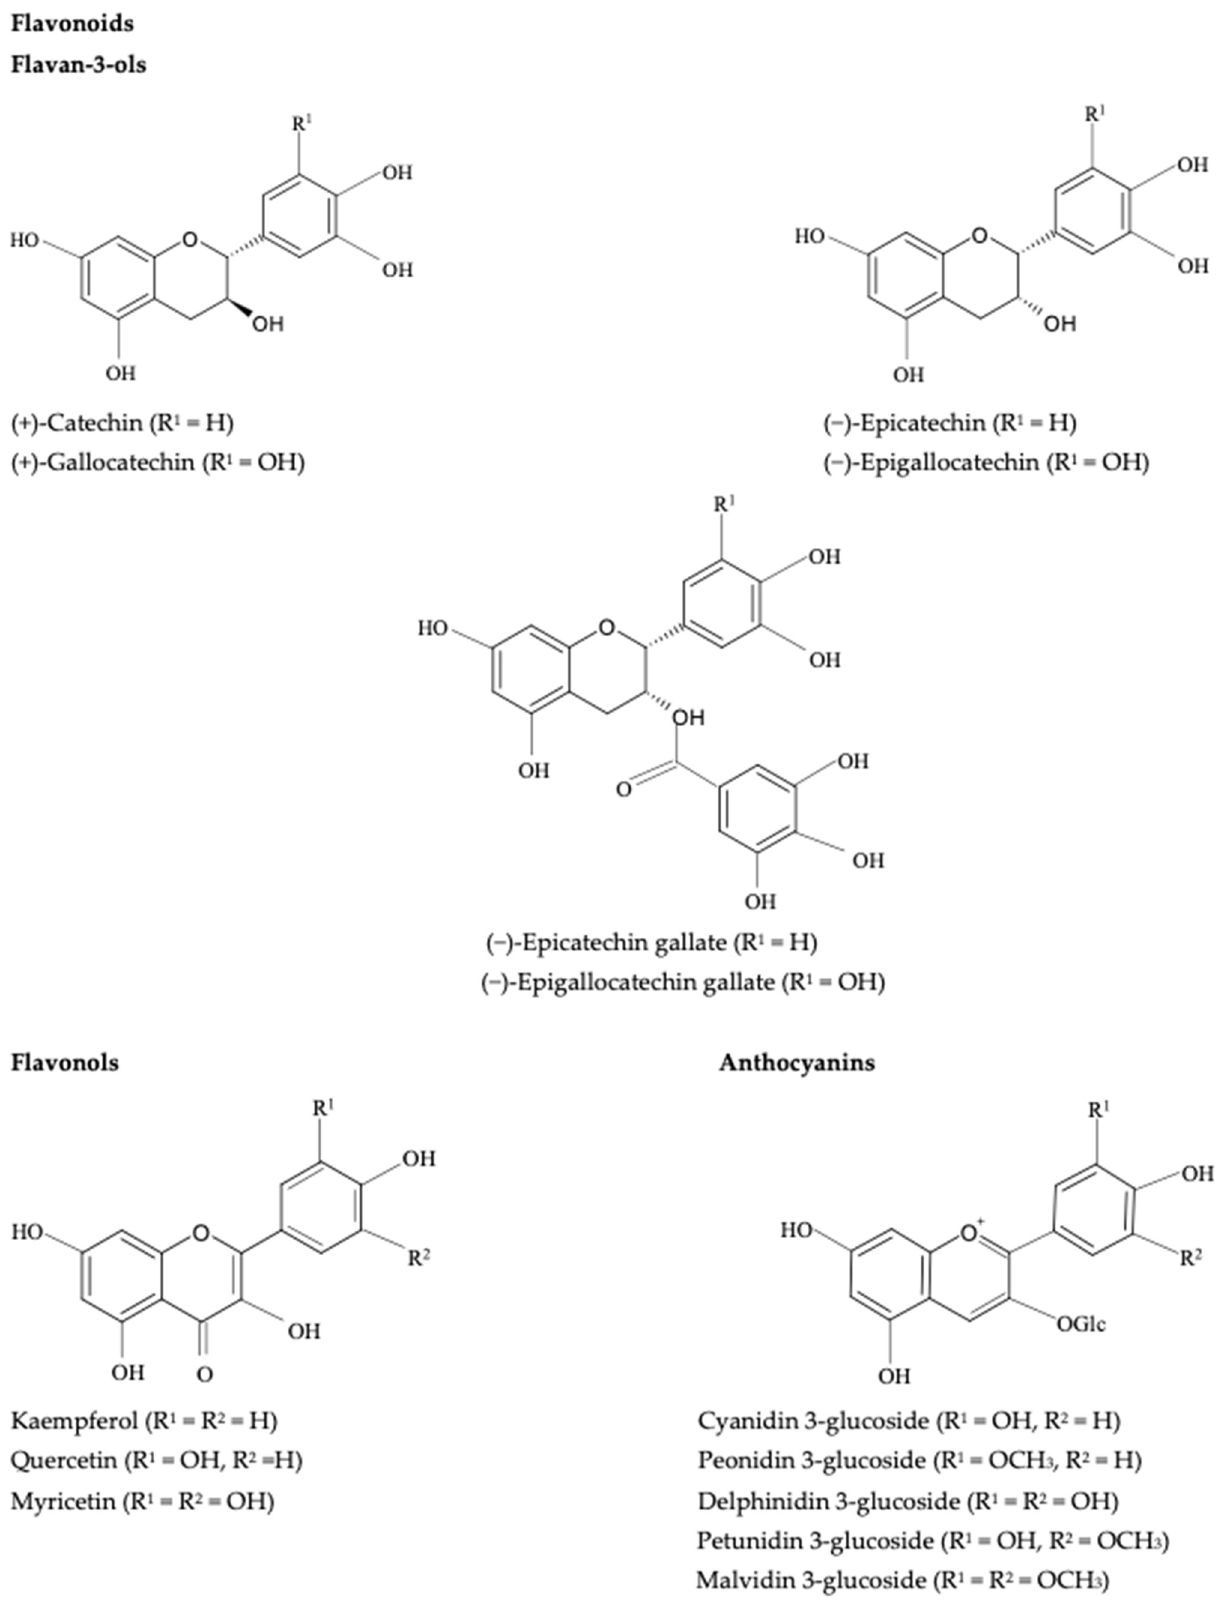
Figure 2. Chemical structure of the most important flavonoids in wine.